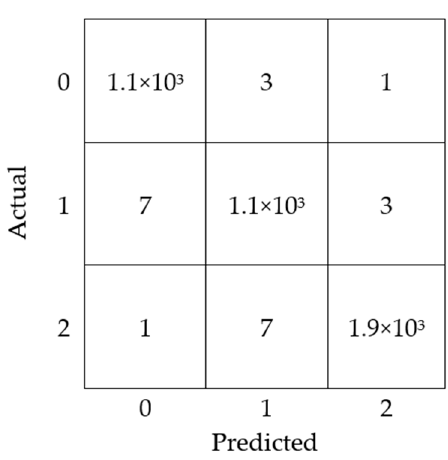
Figure 5. Confusion matrix of random forest (RF) building classification.